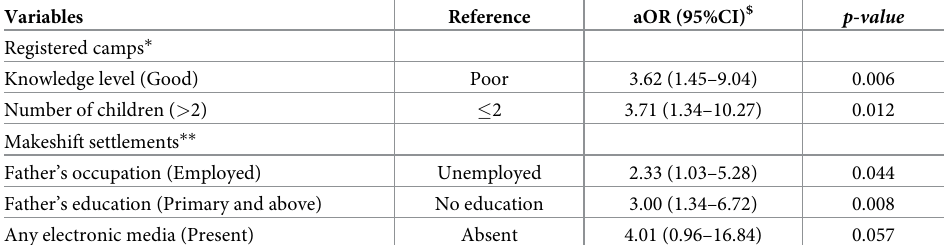
Table 3. Multivariable logistic regression analysis to assess factors associated with good childhood immunization practice among Rohingya parents staying at registered and temporary